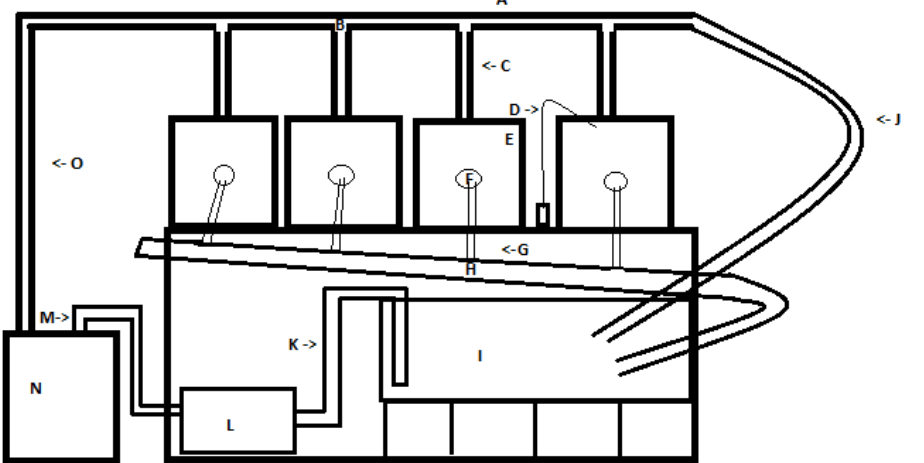
Figure 1. Recirculating water system. ( A ) = upper outflow pipe, ( B ) = water spigot, ( C ) = hose from spigot to tank, ( D ) = air hose, ( E ) = tank, ( F ) = lower output, ( G ) = hose from output to collector pipe, ( H ) = collector pipe, ( I ) = sump, ( J ) = overflow pipe, ( K ) = pipe from sump to water pump, ( L ) = water pump, ( M ) = pipe from pump to chiller, ( N ) = chiller, and ( O ) = side pipe to upper output.